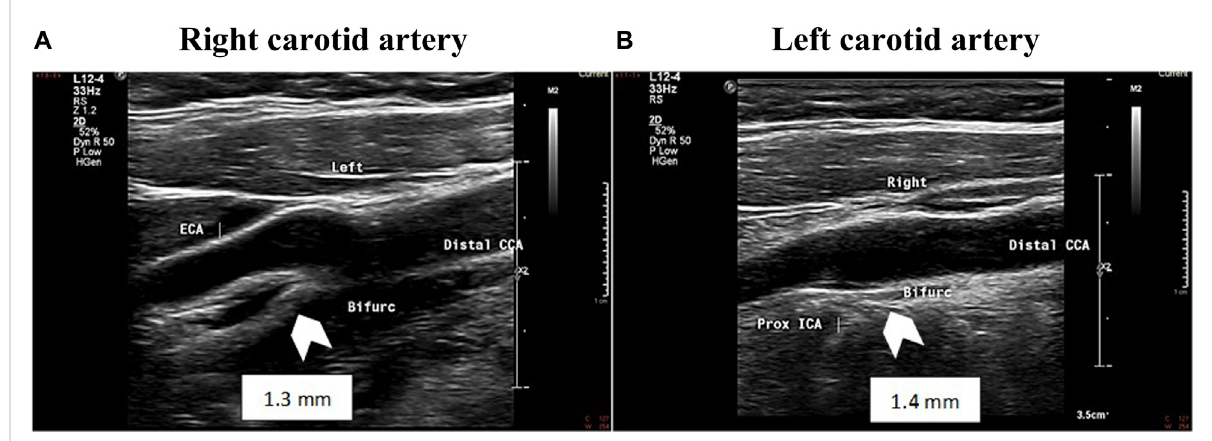
FIGURE 1 Carotid Intima media thickness. Ultrasound image showing measurement of near and far wall IMT in the distal 1 cm of the common carotid artery and increased carotid IMT of the common carotid artery (1.3 mm; 1.4 mm) of patient 2. White arrowhead -indicating increased carotid IMT. CCA, common carotid artery, ICA-internal carotid artery, Bifurc-bifurcation, mm-millimeter. (A) Right carotid artery, (B) B .Left carotid